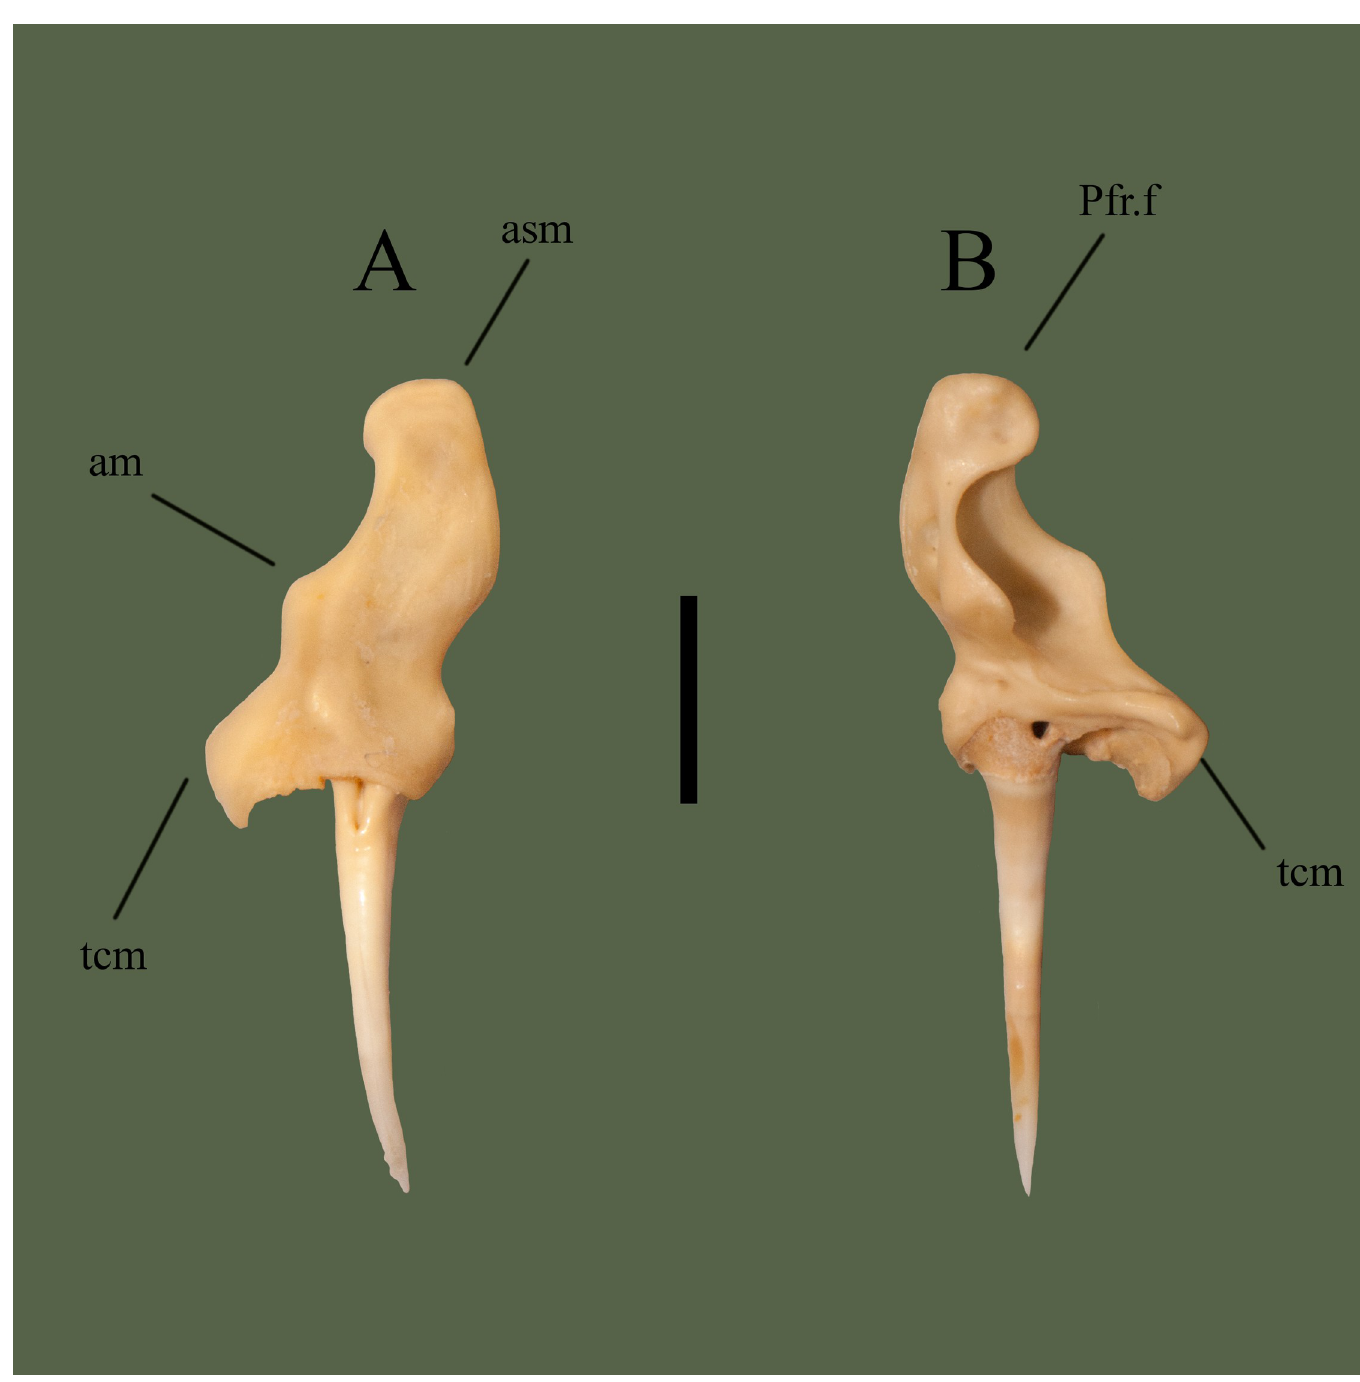
Fig 8. Right maxilla (ETVP 3295) in anterior (A) and posterior (B). Scale bar = 5 mm. Abbreviations: Pfr.f = prefrontal facet; am = anterior process of maxilla; asm = ascending process of maxilla; tcm = transverse crest of